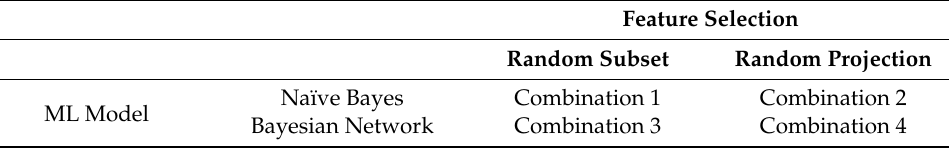
Table 1. Four combinations of the